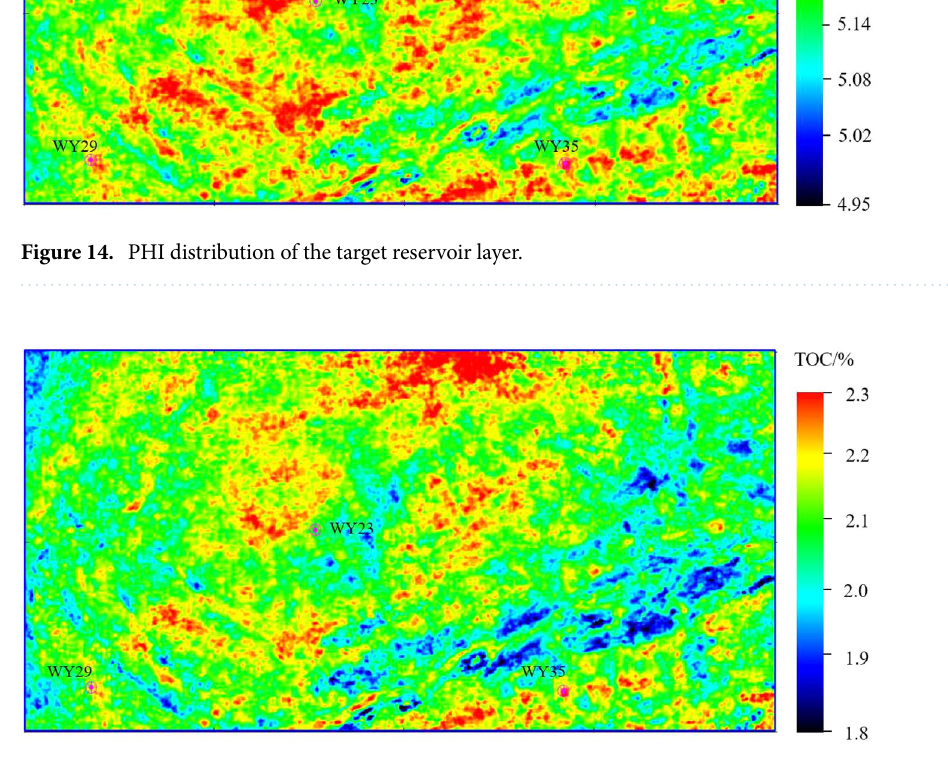
Figure 15. TOC distribution of the target reservoir layer.